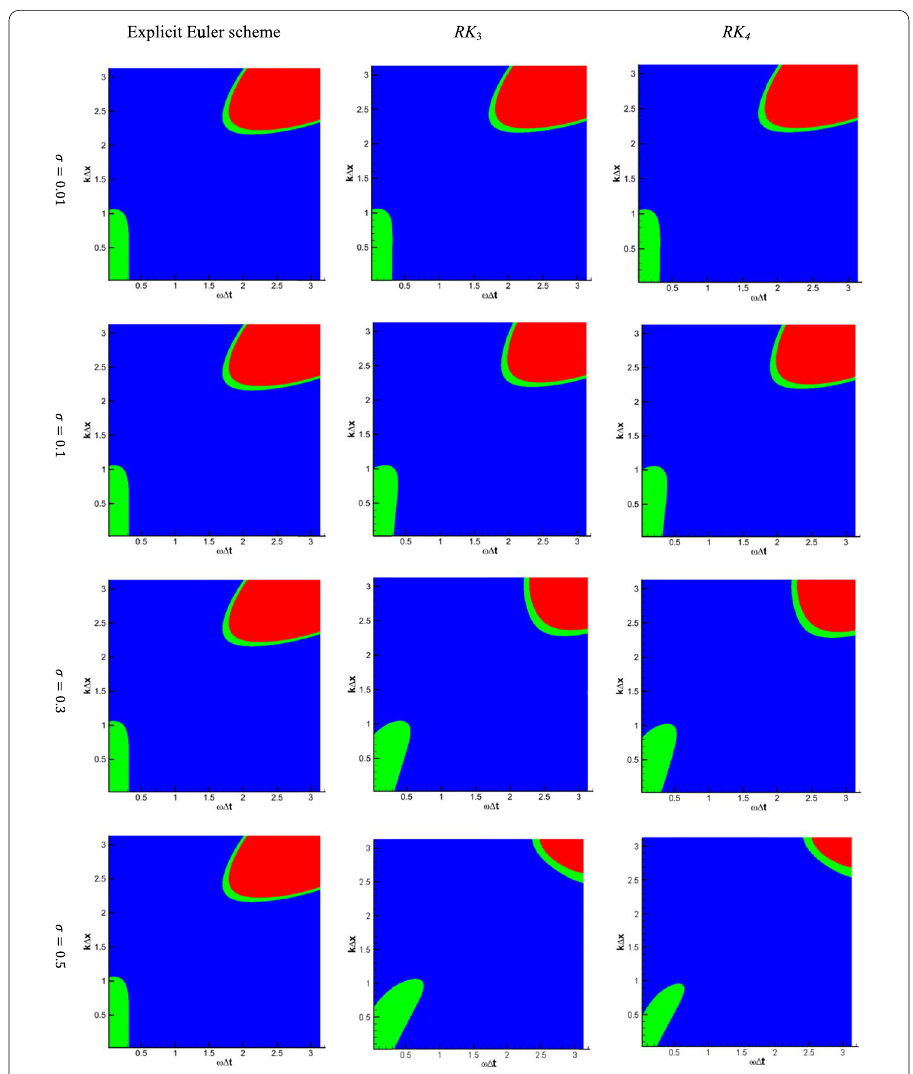
Fig. 2 Distribution of V g / c in the k Δ x vs. ω Δ t space for different time schemes at different σ . UPW5 is used for the spatial discretization. The green region represents the range 0.95–1.05, the red region represents the range > 1.05, and the blue region represents the range <